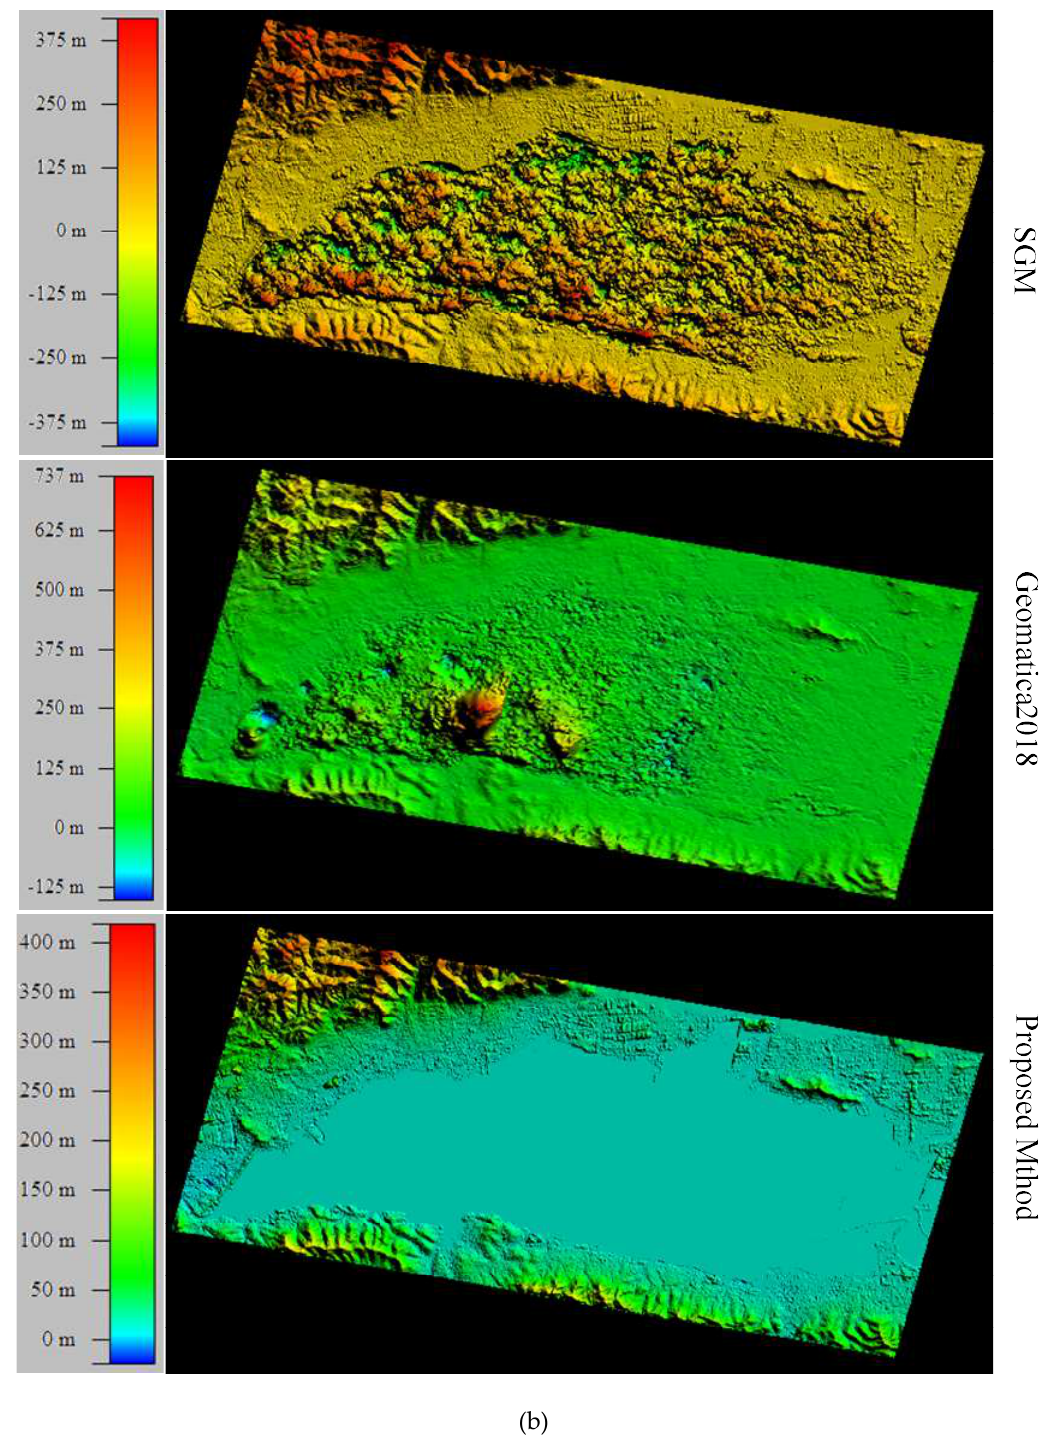
Figure 14. The DSMs generated by SGM, Geomatica2018 and the proposed SGBM. ( a ) Image pair block 1. ( b ) Image pair block 2.